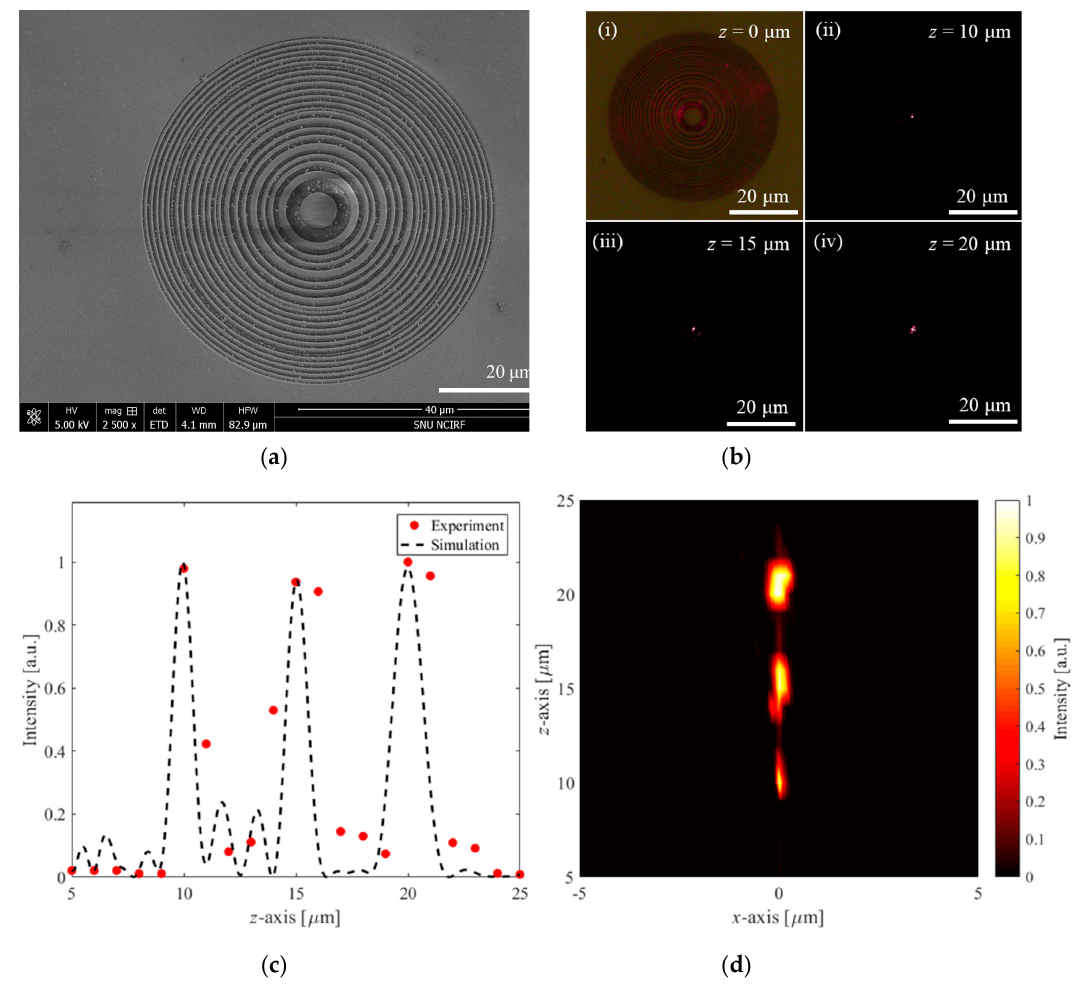
Figure 4. Experimental characterization of the fabricated monochromatic multi-focal MFZP: ( a ) SEM image of the fabricated MFZP. ( b ) Images of the transmitted light through the MFZP with respect to the longitudinal position taken by the optical microscope system for monochromatic incidence at 650 nm: (i) z = 0 µ m, (ii) z = 10 µ m, (iii) z = 15 µ m, and (iv) z = 20 µ m. ( c ) Comparison between the